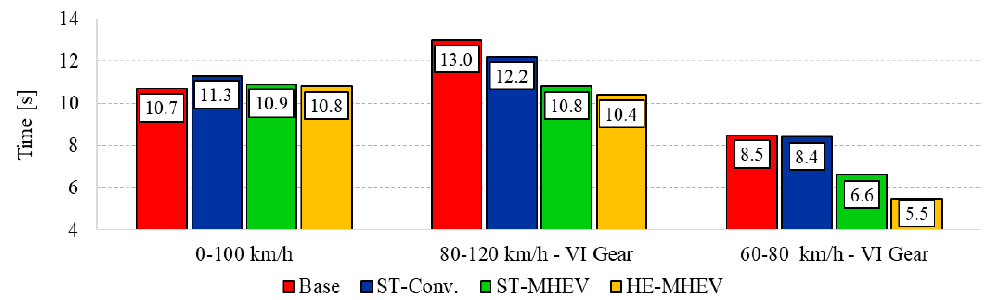
Figure 7. Performance time for the transient maneuvers investigated.